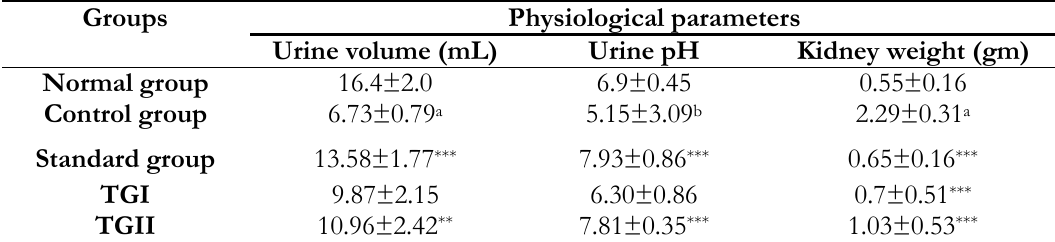
Table III. Effect of EETT on physiological parameters in urolithiatic rats